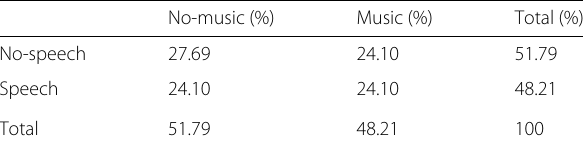
Table 3 Distribution of speech and music events over the 77,936 AUDIAS-balanced—June 2018